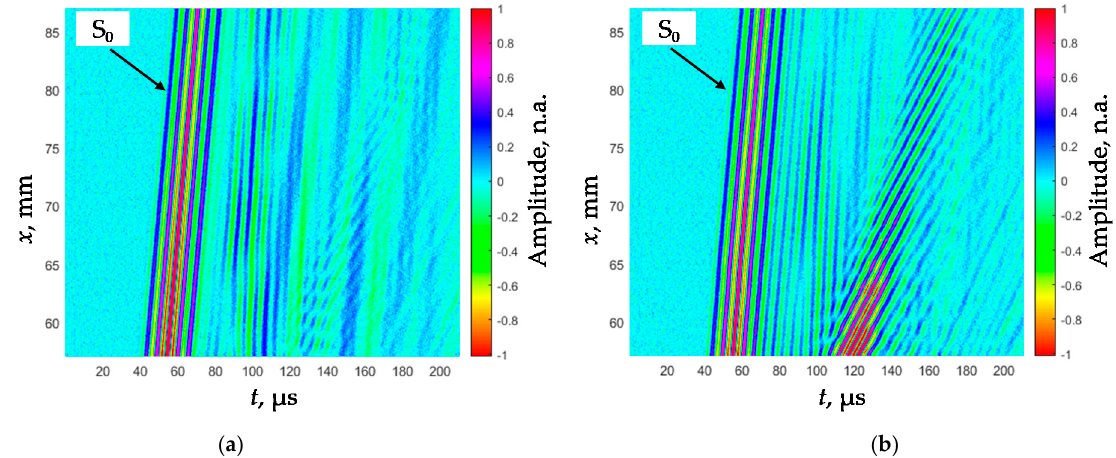
Figure 7. B-scans of the measured amplitudes of the Lamb wave signals in the PVC films of different thickness: ( a ) d 1 = 150 µm, ( b ) d 2 = 200 µm.